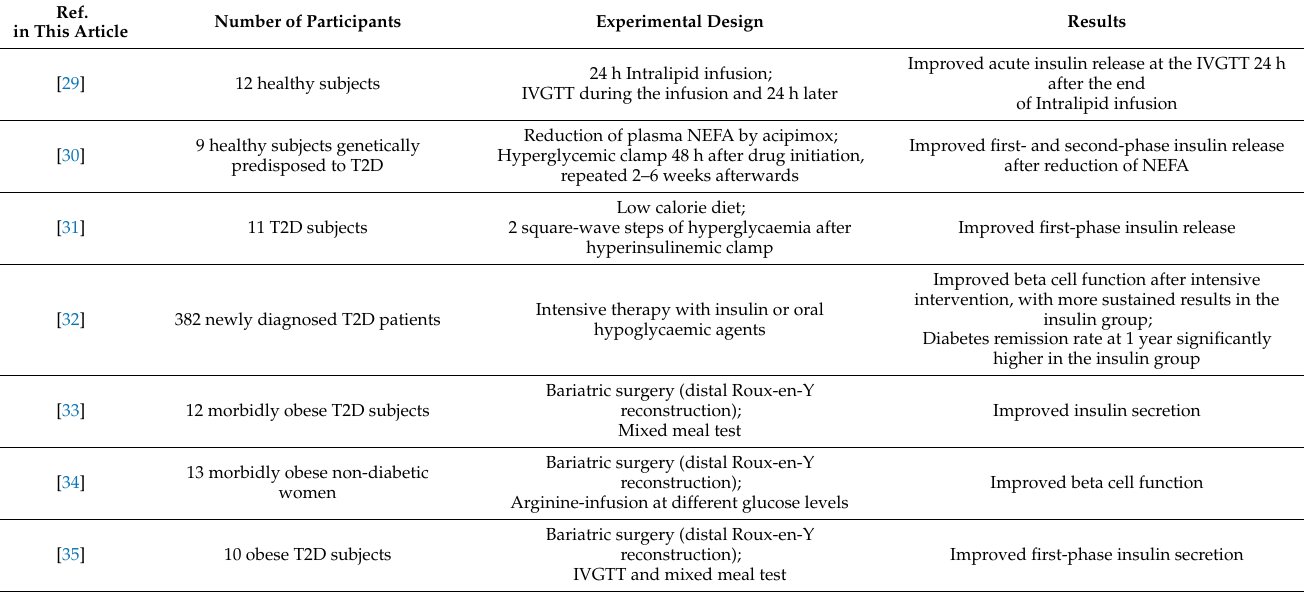
Table 2. Studies showing in vivo recovery of beta cell